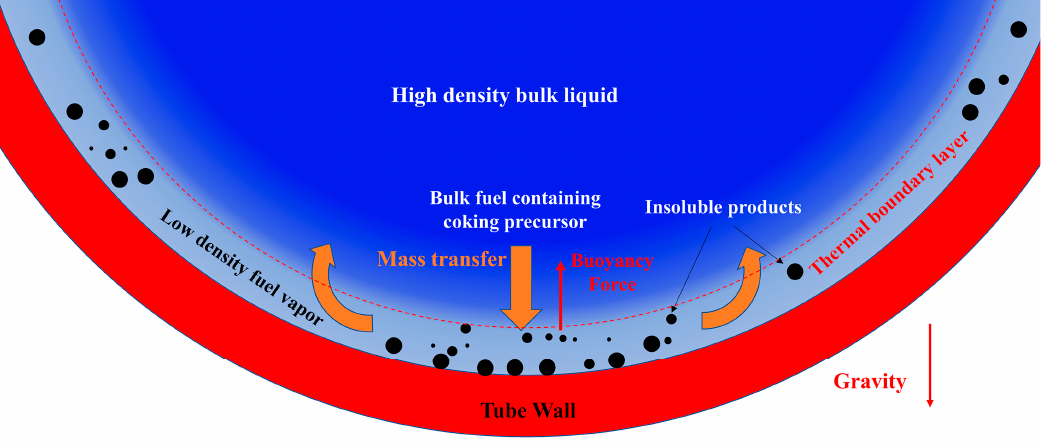
Figure 8. Schematic diagram of the mass transfer on the cross-section of the heat exchange tube.